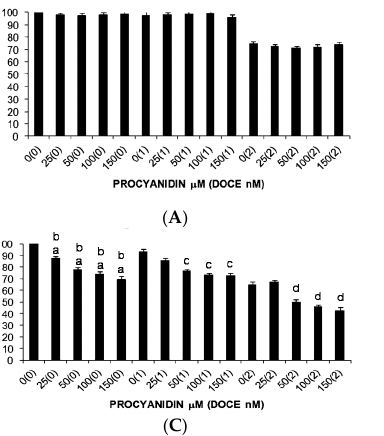
Figure 2. Trypan blue dye exclusion assay results showing viability of DU 145 PC cells under different concentrations of the test compound (ProB2, DOCE, ProB2 + DOCE) at 24 h ( A ), 48 h ( B ) and 72 h ( C ). Columns, mean; bars, SD (n = 3). a represents the significant difference between ProB2 treatment alone for 72 h and control treatment at 24 h; b represents the significant difference between ProB2 treatment alone for 72 h and control treatment at 48 h; c represents the significant difference between ProB2 treatment alone for 72 h and 1 nM DOCE treatment alone; d represents the significant difference between ProB2 treatment alone for 72 h and 2 nM DOCE treatment alone. Abbreviations: CAT, catechin; DOCE, docetaxel; ProB2, procyanidin B2.